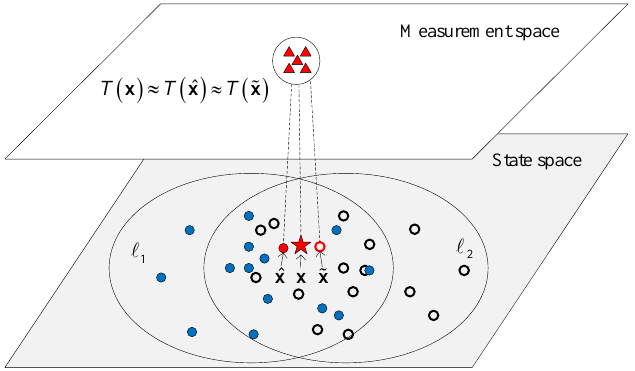
Figure 1. A sketch diagram to show the measurements affected by a target are associated with two tracks. Solid dots denote the particles of track (cid:96) 1 , Hollow dots denote the particles of track (cid:96) 2 and triangles denote the associated measurements of x , ˆ x and ˜ x